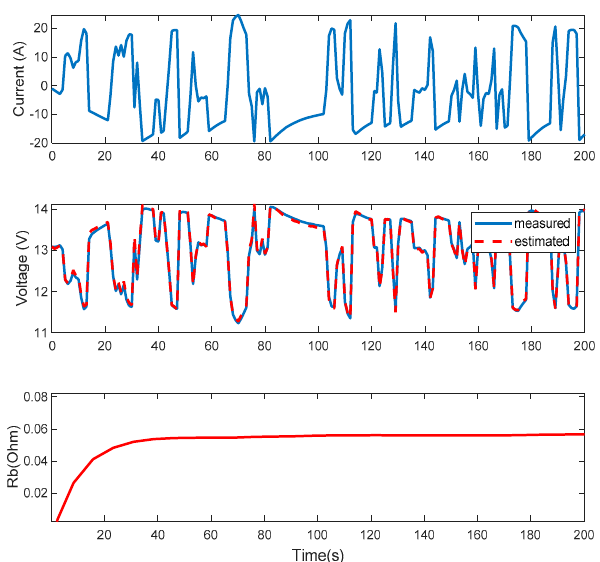
Figure 9. Battery internal resistance identification under constant current (experimental).